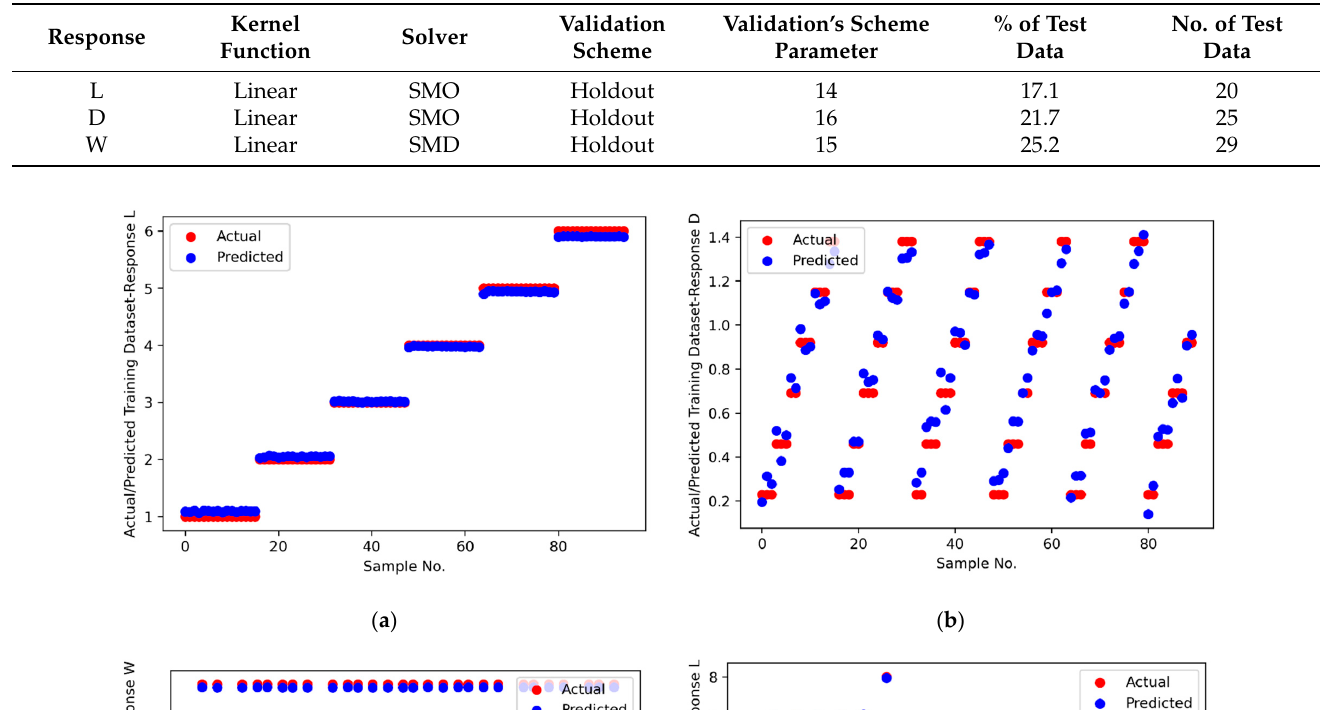
Table 9. Best Parameters of the SVR model for responses L, D, and W.